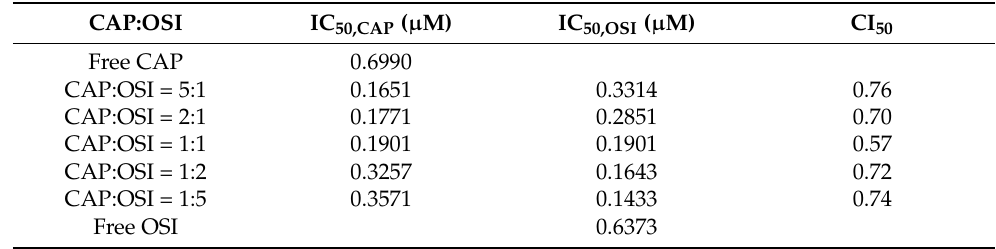
Table 1. IC 50 values of free CAP, free OSI, and CAP/OSI physical mixture with different drug ratios ( n = 3).